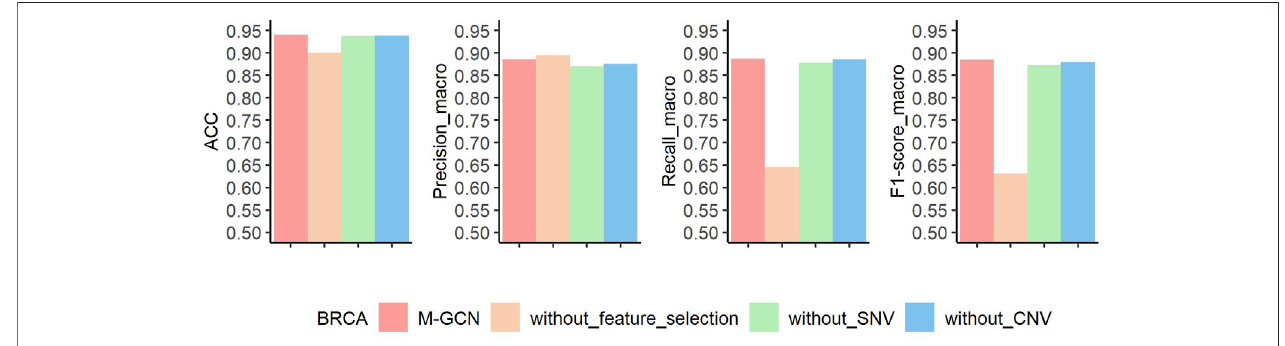
FIGURE 6 | Results of ablation experiment of M-GCN in BRCA. Pink bar represents the fi nal performance of M-GCN, orange bar represents the performance of M-GCNwithoutfeatureselection,greenbarisfortheperformanceofM-GCNwithoutSNVfeatures,andbluebarisfortheperformanceofM-GCNwithoutCNVfeatures.